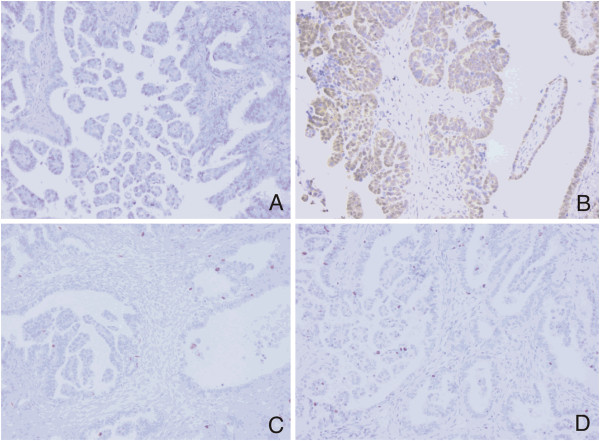
Representative immunostaining patterns of low-grade OSCs. Negative p53 immunoexpression (A; original magnification, × 200), positive MAPK immunoexpression (B; original magnification, × 200), negative topoII alpha immunoexpression (C; original magnification, × 200), low Ki67 proliferative activity (D; original magnification, × 200).